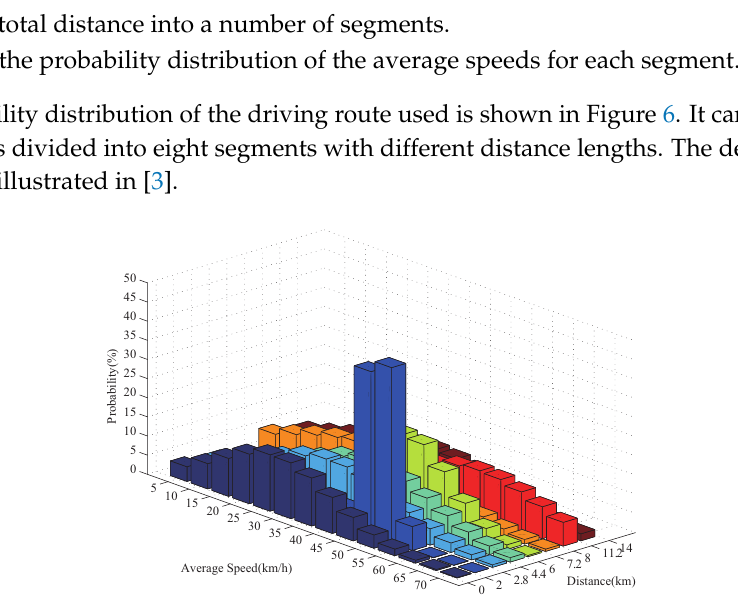
Figure 6. Probability distribution of the average speed in each